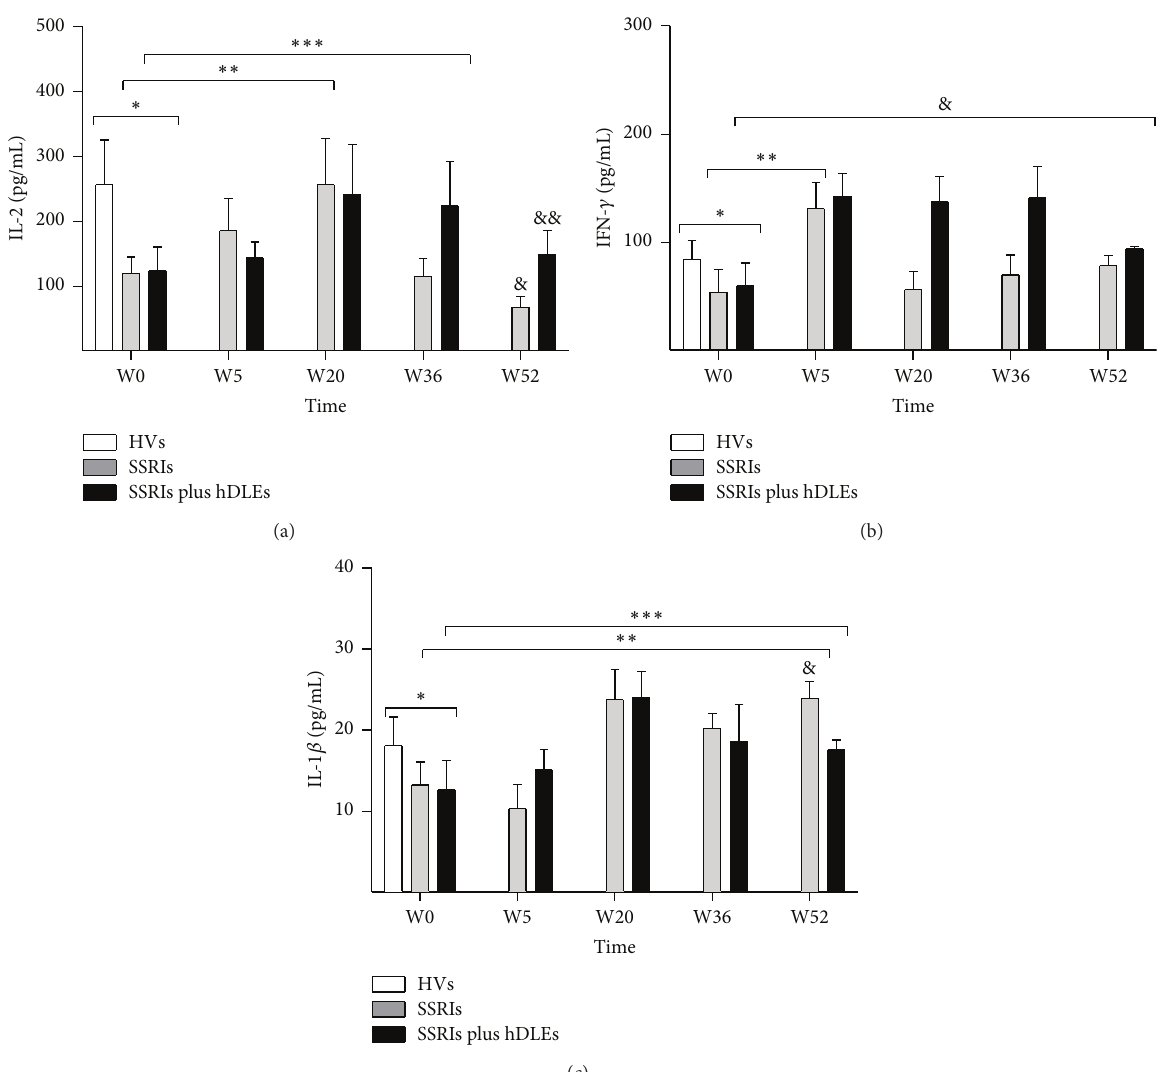
Figure 3: Serum proinflammatory cytokines detected by capture ELISSA assay in HVs and MDD patients. Patients were treated with SSRIs or SSRIs plus hDLEs during 52 weeks of study. The statistical analyses were as follows. First, the patient group before antidepressant treatment (W0) was compared with the control group (HVs). Second, the values before the antidepressant treatments (W0) were compared with those during the treatment (W5, W20, W36, or W52) in patients. Third, the data of patients at W52 versus HVs were compared. IL-2 (a), IFN- 𝛾 (b), and IL-1 𝛽 (c): ∗ 𝑃 < 0.0001 , significant difference before treatments versus HVs. IL2: ∗∗ 𝑃 < 0.0001 between SSRIs treatment at W5 and W20 versus W0. ∗∗∗ 𝑃 < 0.001 between SSRIs plus hDLEs treatment at (W) 5, 20, and 36 versus W0. & 𝑃 < 0.0001 between SSRIs treatment at W52 versus HVs. && 𝑃 < 0.001 between SSRIs plus hDLEs treatment at W52 versus HVs. IFN- 𝛾 : ∗∗ 𝑃 < 0.0001 between SSRIs treatment at W5 versus W0. & 𝑃 < 0.0001 between SSRIs plus hDLEs treatment at (W) 5, 20, 36, and 52 versus W0. IL-1 𝛽 : ∗∗ 𝑃 < 0.001 between SSRIs treatment at (W) 5, 20, 36, and 52 versus W0. ∗∗∗ 𝑃 < 0.0001 between SSRIs plus hDLEs treatment at (W) 5, 20, 36, and 52 versus W0. & 𝑃 < 0.0001 SSRIs treatment at W52 versus HVs. Data are expressed as mean ± SD. HVs: healthy volunteers; MDD: major depression disorder; W: